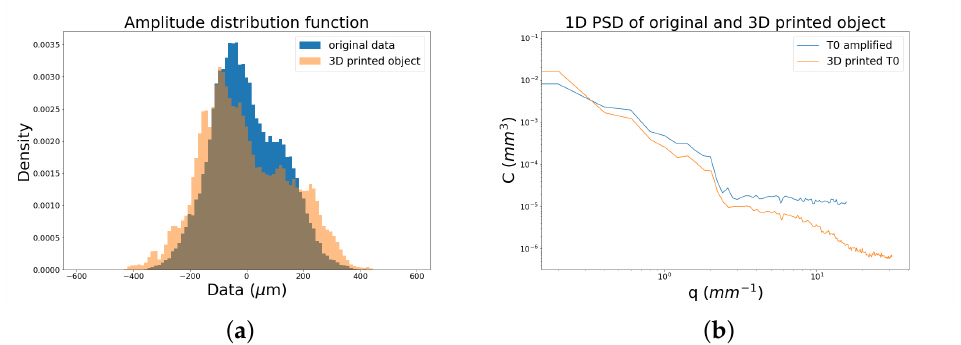
Figure 6. Signal of the enhanced surface and 3D printed replica: ( a ) height distribution and ( b ) power